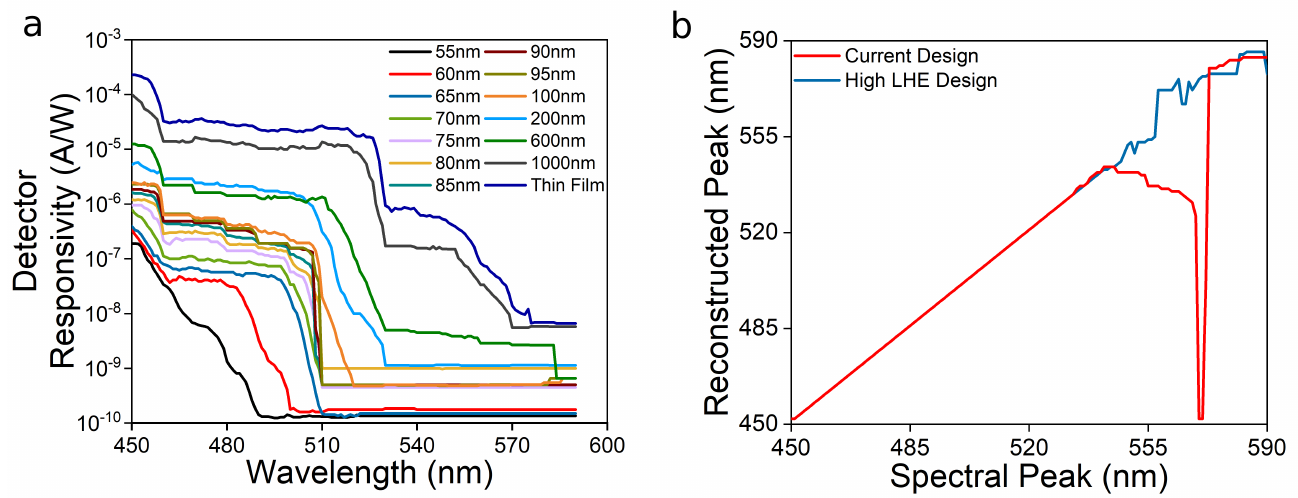
Figure 6. ( a ) Experimentally measured responsitivities of 14 photodetectors of different nanopillar diameters (data adapted from Ref. [17]). The LHEs of these devices are shown as “prior result” in Figure 3. ( b ) The spectral reconstruction performance determined using the responsivity matrix R ij , where i and j correspond to the i − th photodetector and wavelength λ j , respectively; the theoretical photocurrent I i of the i − th photodetector determined by I i = R × δ ( λ ) , where δ is the Dirac delta function; and Equation (2). The “current design” corresponds to the responsivity matrix shown in ( a ). The “high LHE design” corresponds to the design shown in Figure